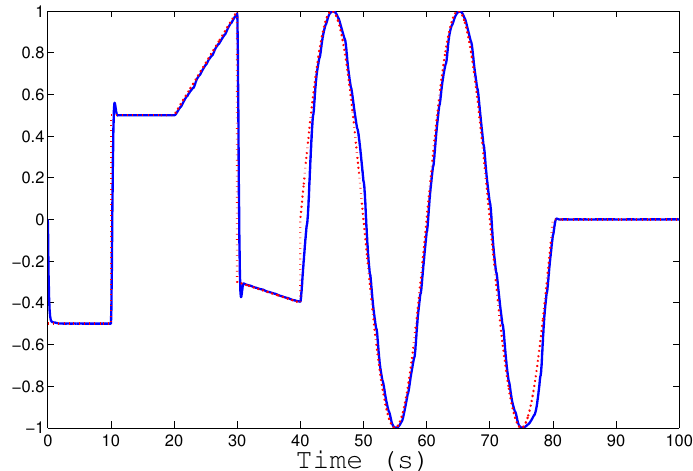
Figure 2. Numerical results: red-dotted line is θ ( t ) and the other one is ˆ θ ( t ) .